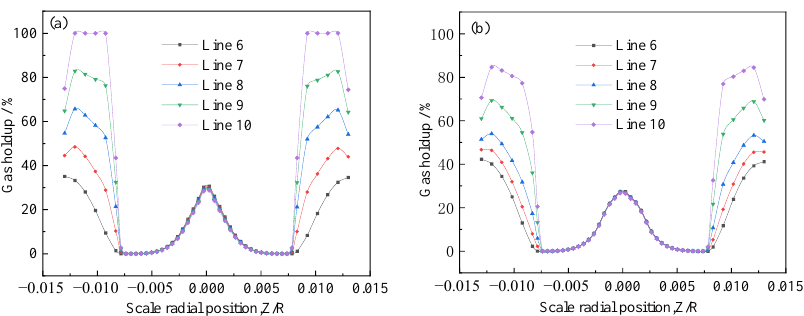
Figure 5. Distribution diagram of gas holdup at different sections at an ( a ) inlet flow velocity 6.5 m/s and ( b ) inlet flow velocity 7.5 m/s.